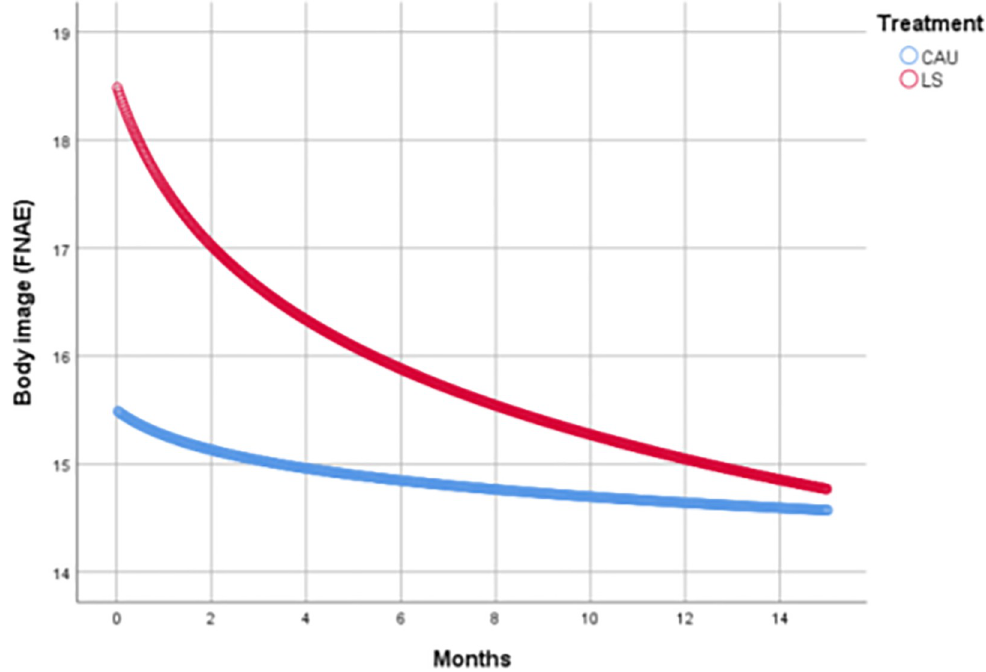
Fig 4. Body image scores over